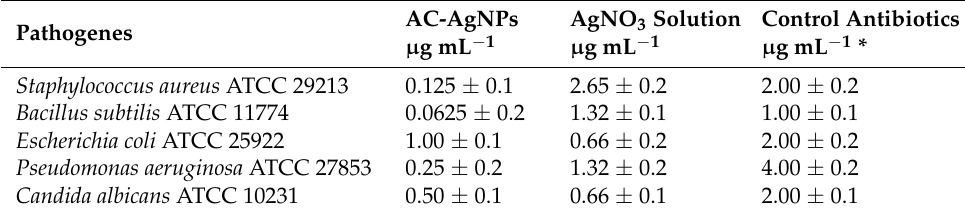
Table 1. MIC values (µg/mL) of AC-AgNPs, AgNO 3 solution, and standard antibiotics.